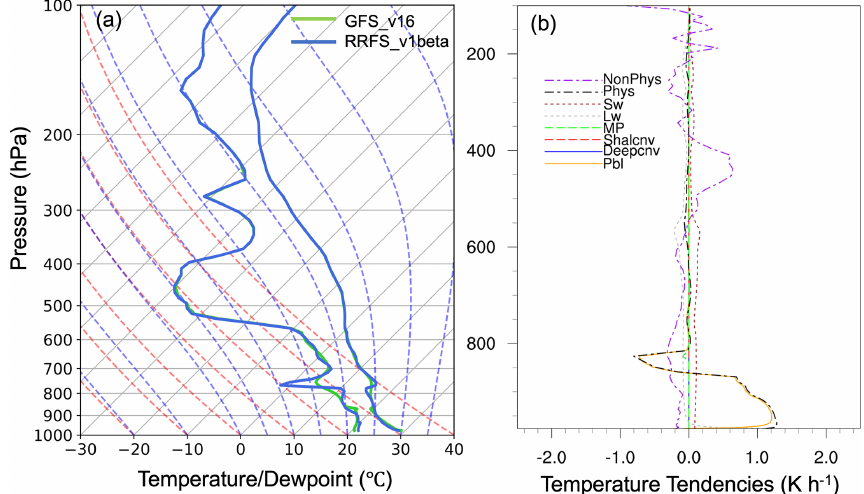
Figure 5. (a) Skew-T log-P plot for SCM runs with physics suites GFS v16 (GFS_v16) and RRFS v1beta (RRFS_v1beta), initialized at 00:00UTC on 23 July 2020 at the Atmospheric Radiation Measurement Southern Great Plain central facility site (36.61 ◦ N, 97.49 ◦ W) and valid at forecast hour 15. (b) Tendencies from the GFS v16 physics suite valid at the same time for the different contributing processes (Pbl: planetary boundary layer; Deepcnv/Shalcnv: deep/shallow convection; MP: microphysics; Lw/Sw: longwave/shortwave radiation; Phys: all physics tendencies; NonPhys: non-physics tendencies, e.g.,